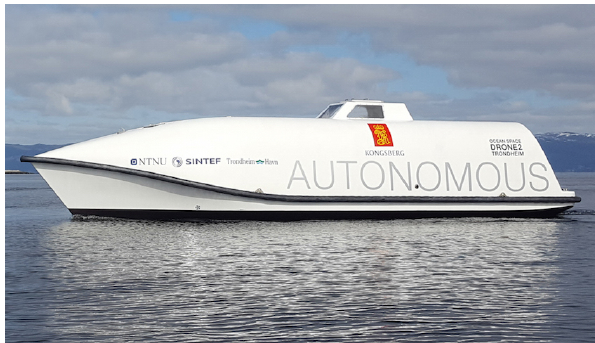
Figure 9: The Kongsberg Seatex Ocean Space Drone 2, which is identical to the Ocean Space Drone 1 (OSD1). Courtesy of Kongsberg